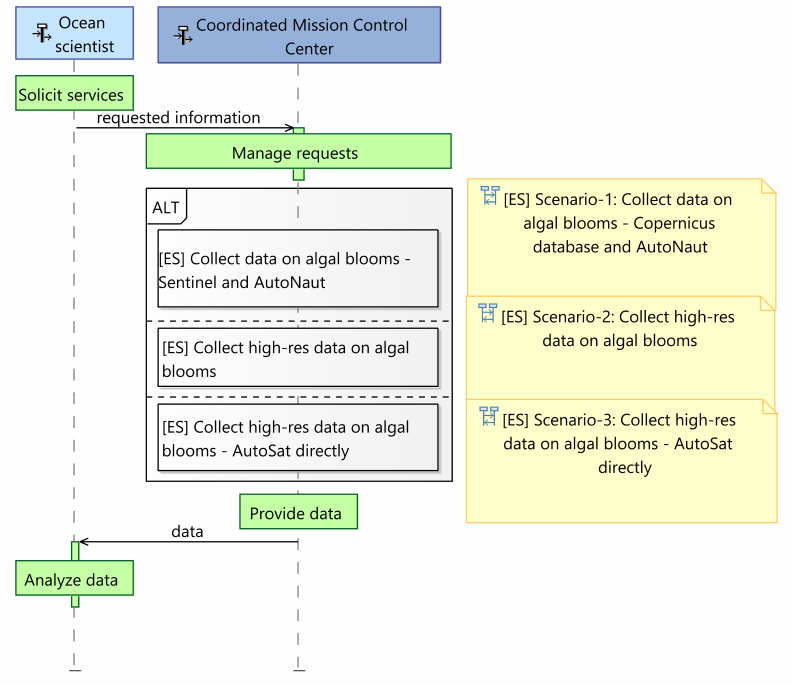
Figure 4. Exchange scenario (ES) overview in a lifeline format. The dashed lines indicate the lifeline of the actor, and the solid lines indicate a functional exchange between a source and a target actor. A green box indicates a function, the grey box with [ALT] indicates choices between different ES. The yellow sticky notes are there for linking between diagrams for the user. The figure is modeled using